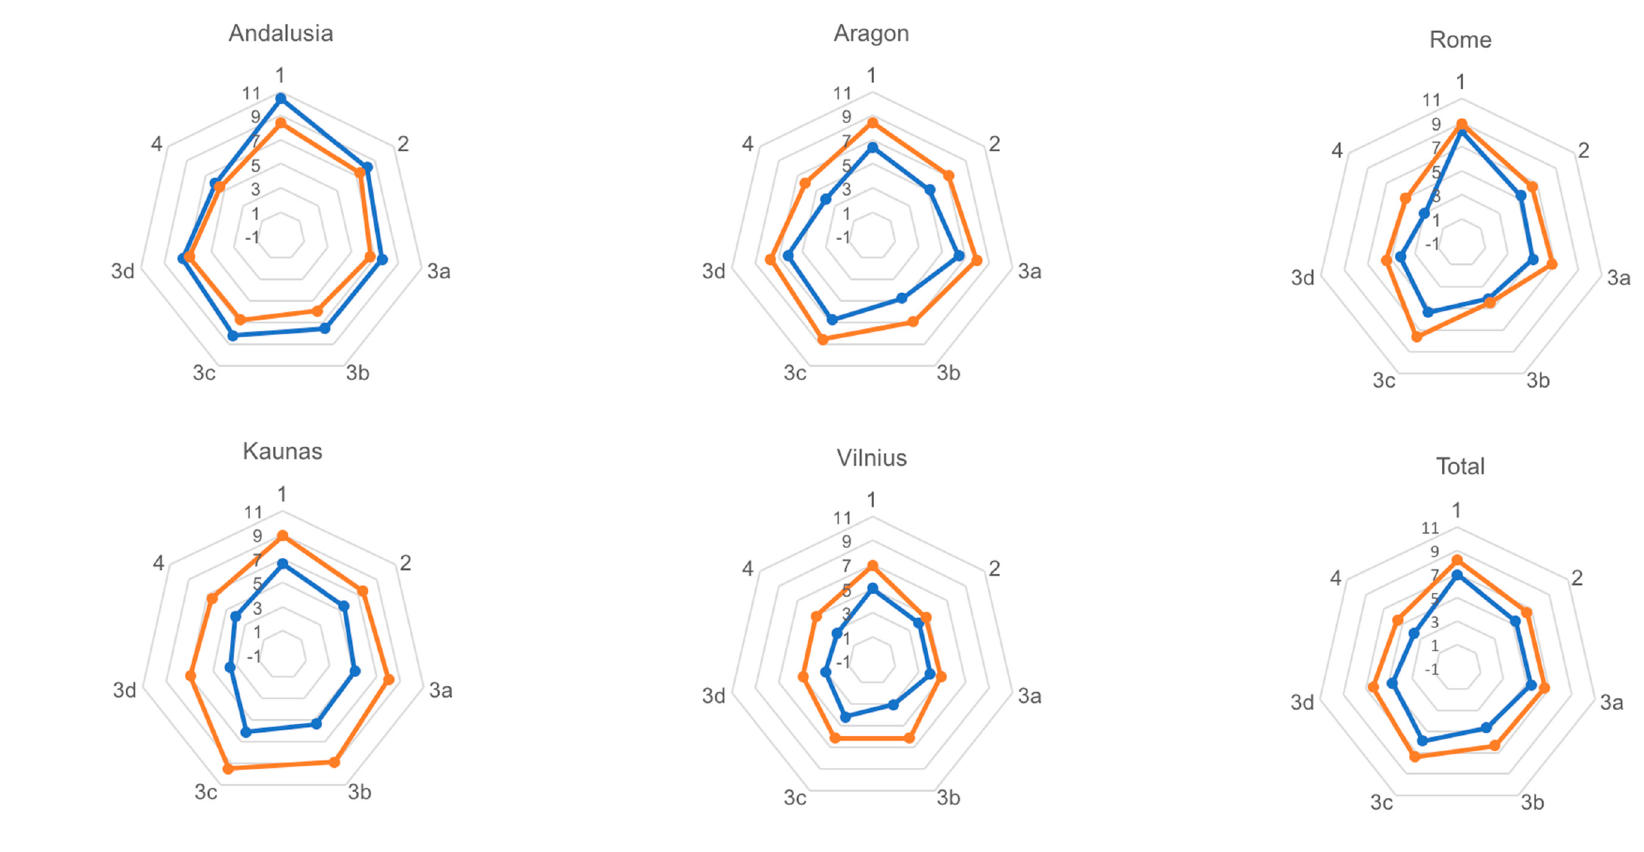
Figure 1. The ACIC mean scores before (pre) and after (post) implementation of the Integrated Multimorbidity Care Model (IMCM), by site and total sample. 1. Delivery system organization; 2. Community linkages; 3a. Self-management support; 3b. Decision support; 3c. Delivery system design; 3d. Clinical information systems; 4. IMCM component integration.